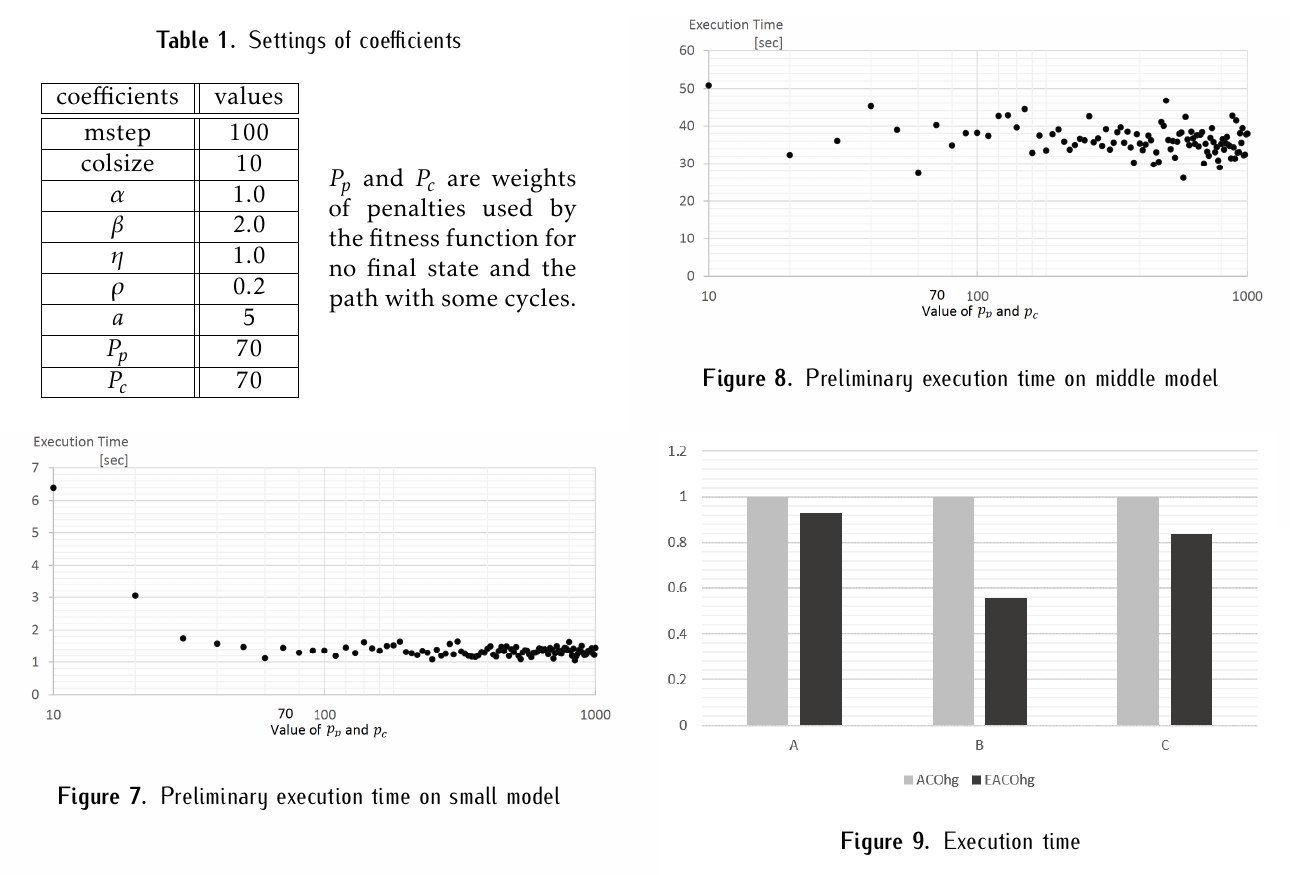
Figure 9. Execution